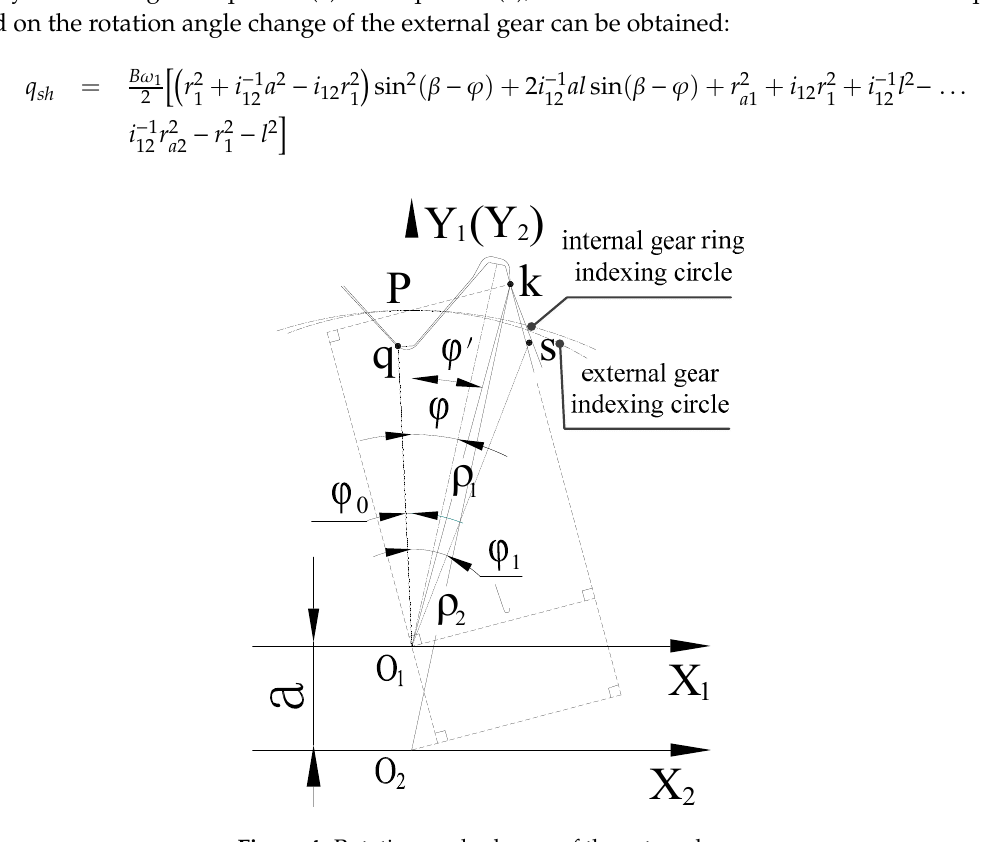
Figure 4. Rotation angle change of the external gear.